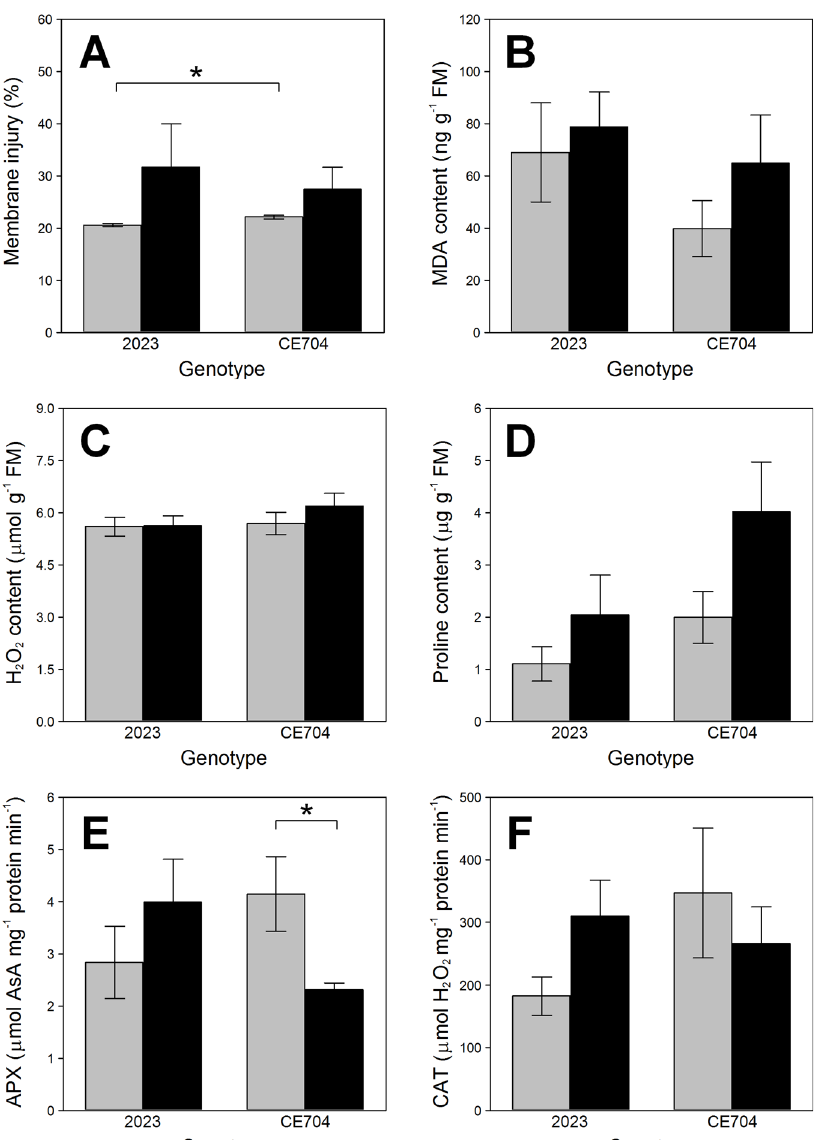
Fig 5. The contents of proline, H 2 O 2 , malondialdehyde (MDA), the antioxidant activities and the index of membrane injury in two maize genotypes (2023 and CE704). Plants were either subjected to normal watering (control; grey columns) or to 14 days of withholding water (stress; black columns). Mean values ± SEM are shown (n = 6 for the contents of MDA, n = 4 for the other parameters). Asterisks indicate significant ( p (cid:20) 0.05; (cid:3) ) or highly significant ( p (cid:20) 0.01; (cid:3)(cid:3) ) differences between mean values according to Tukey’s tests made separately for each genotype (in case of the differences between control and stress treatment) or for each treatment (in case of the differences between both genotypes).AsA ... ascorbate, APX ... ascorbate peroxidase, CAT ... catalase, FM ... leaf fresh